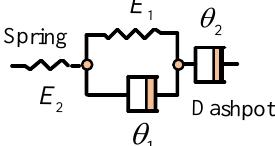
Figure 2. Burgers model. Figure 3 is the flow chart of the analytical process for the viscoelastic solutions of the composite pipes, which is described in detail in Sections 2.1 – 2.3.